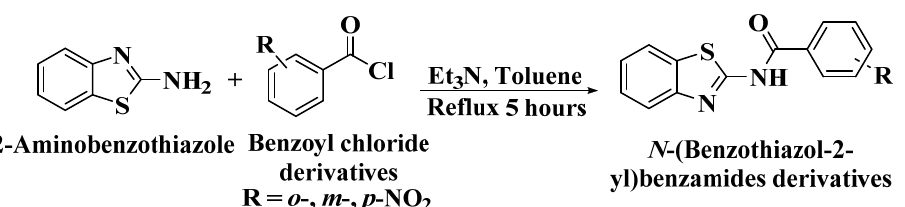
Scheme 1. The schematic reaction of 2-aminobenzothiazole with o -, m - and p -nitrobenzoyl chloride to synthesise I, II and III, respectively.